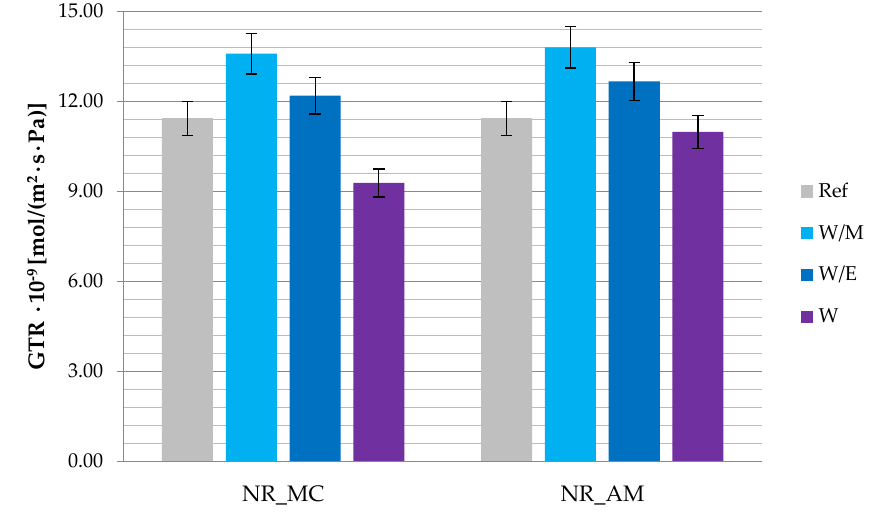
Figure 12. The gas transmission rate (GTR) values of tested vulcanizates.